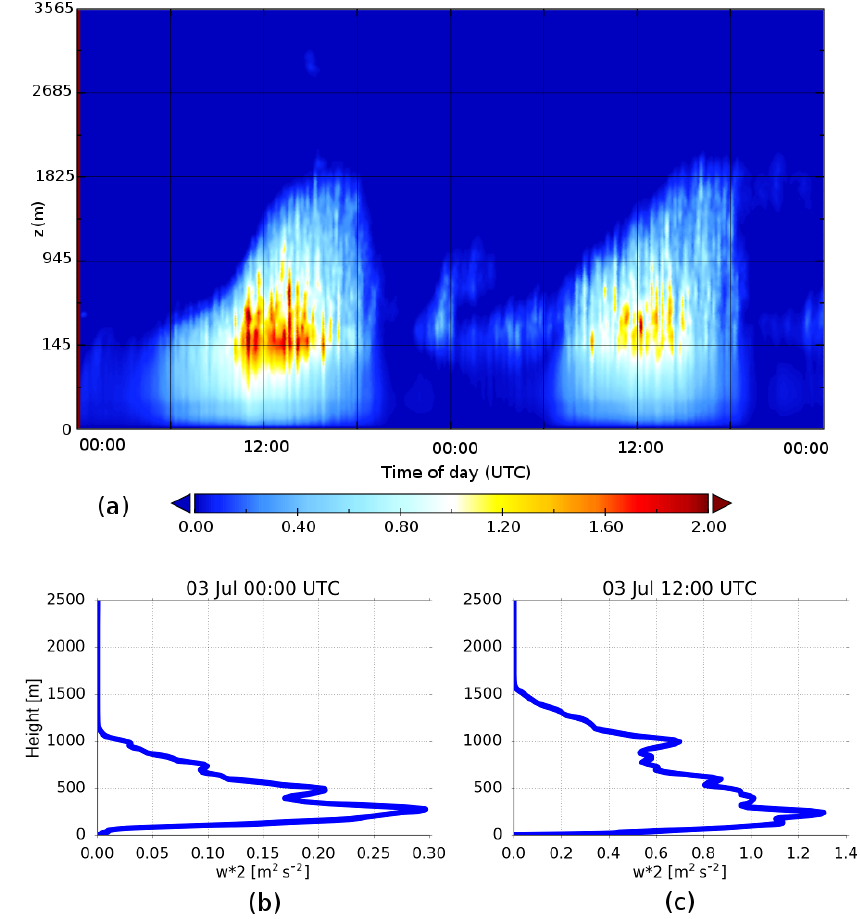
Figure 8. (a) Time–height cross section of the variance of the vertical velocity component (top), and vertical profiles of the same quantity at two selected times: (b) 3 July 00:00UTC and (c) 3 July 12:00UTC